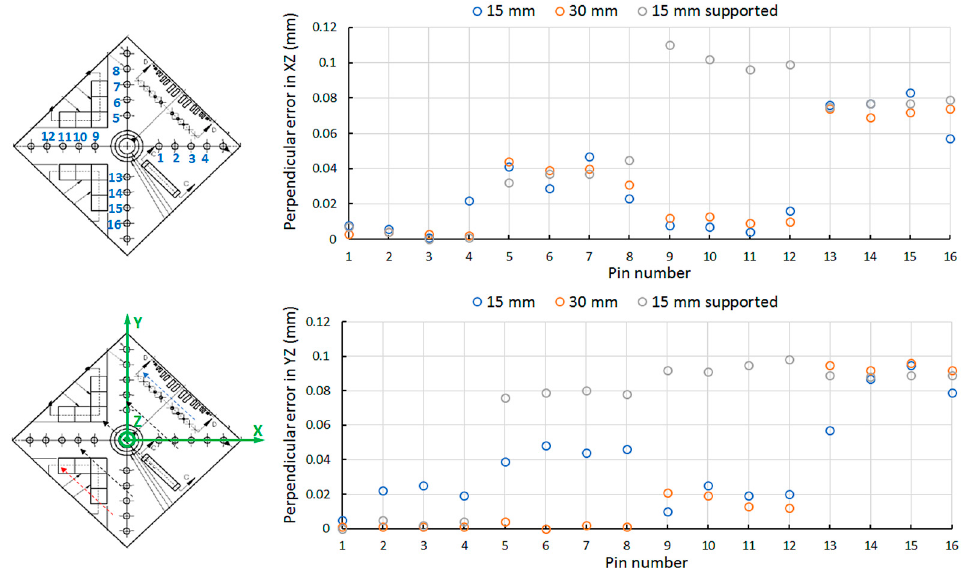
Figure 4. Geometrical distortion of each pin number with respect to the XZ and YZ planes.